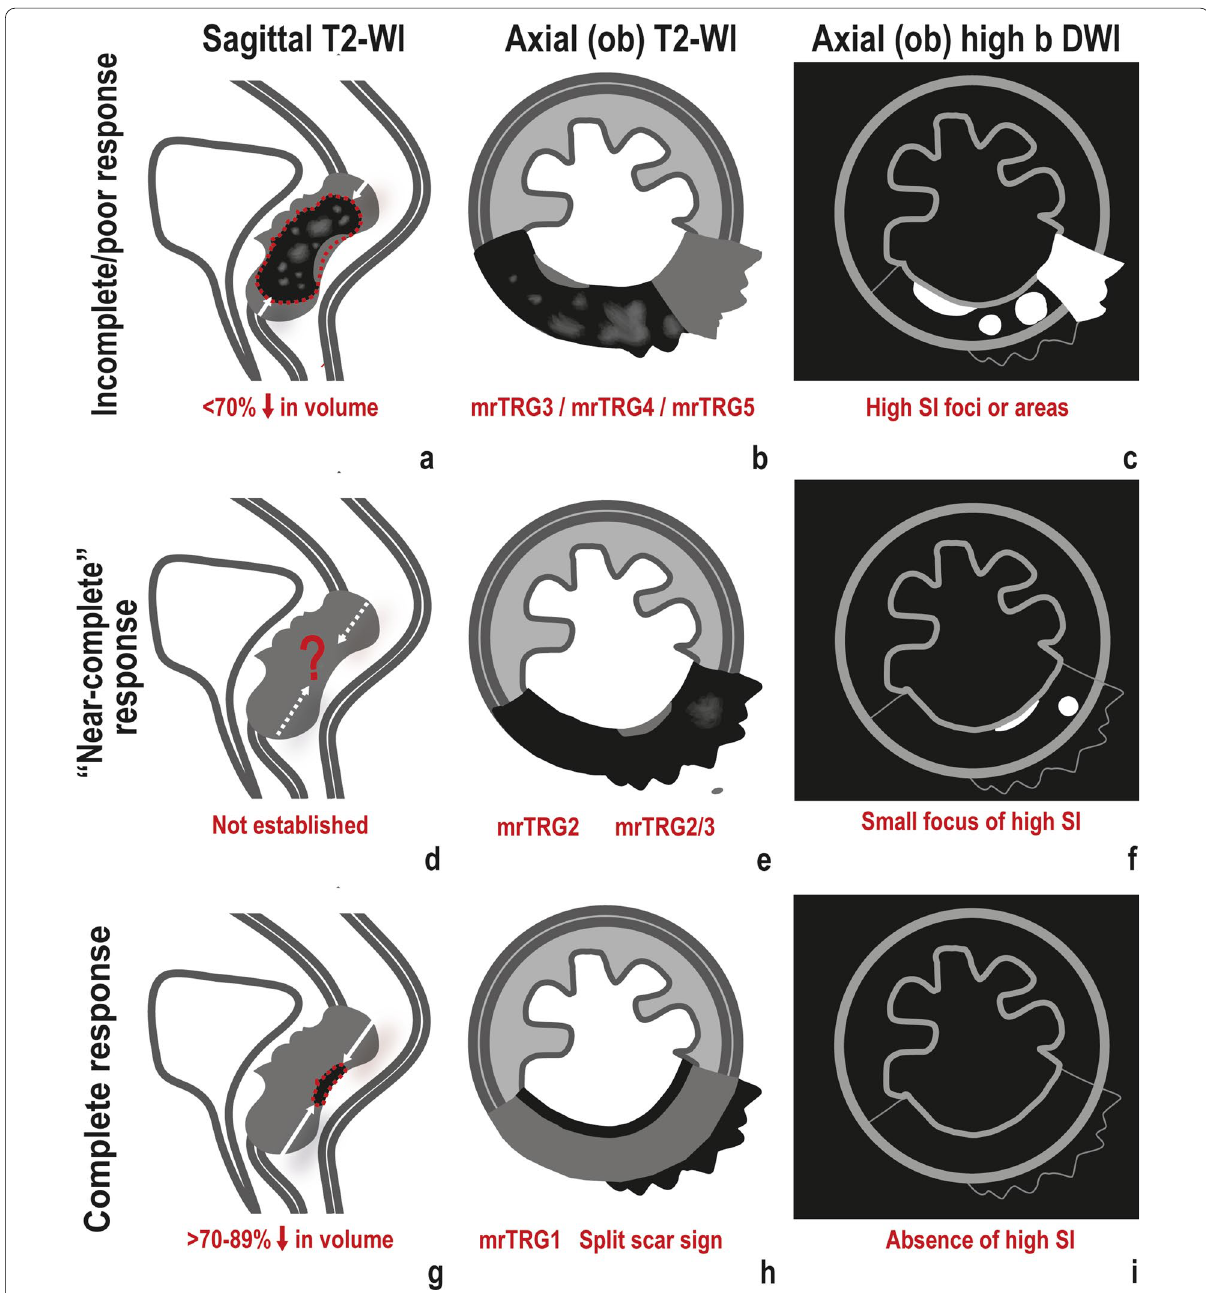
Fig. 1 Primary tumour response. An incomplete/poor response to NAT may be characterised by ( a ) little reduction in tumour volume, < 70%. b mrTRG3 or higher, translating into the presence of residual intermediate “tumour” signal intensity on T2-WI; c Residual high signal intensity at tumour bed on DWI. “ Near-complete” responses fall on the good response group and as such, a large reduction in tumour volume may be expected but a cutoff is not established ( d ). e On T2-WI, mrTRG2—scar with “dense fibrosis”—and mrTRG2/3, in which a tiny focus of residual intermediate signal may still be visible, are included; f Also, a small residual focus of high signal intensity on high b-value DWI may be admitted. Complete responses are characterised by a very large reduction in tumour size, > 70–89% ( g ). h on T2-WI, they may present as mrTRG1, characterised by the presence of a linear/crescenteric 1–2 mm hypointense scar at the endoluminal aspect of the tumour bed or normalisation of the rectal wall; they may also present with a positive split scar sign, which includes mrTRG1s and scars with an additional peri-rectal, usually irregular, layer of hypointense tissue, separated from the inner linear hypointense linear/crescentic scar by an intermediate signal intensity thickened and partially fibrotic muscularis propria ; i No high signal intensity at tumour bed on DWI is